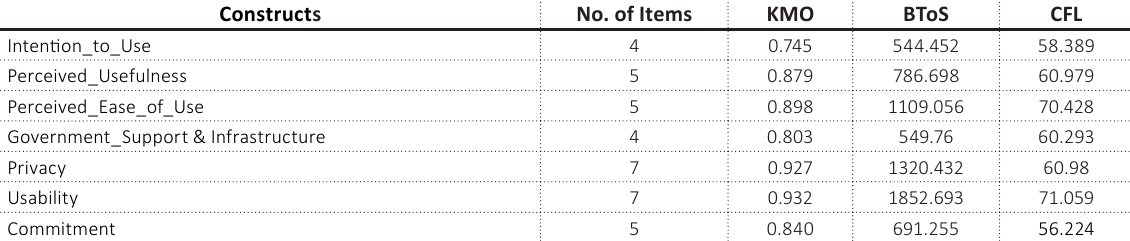
Table 5. Construct validity analysis